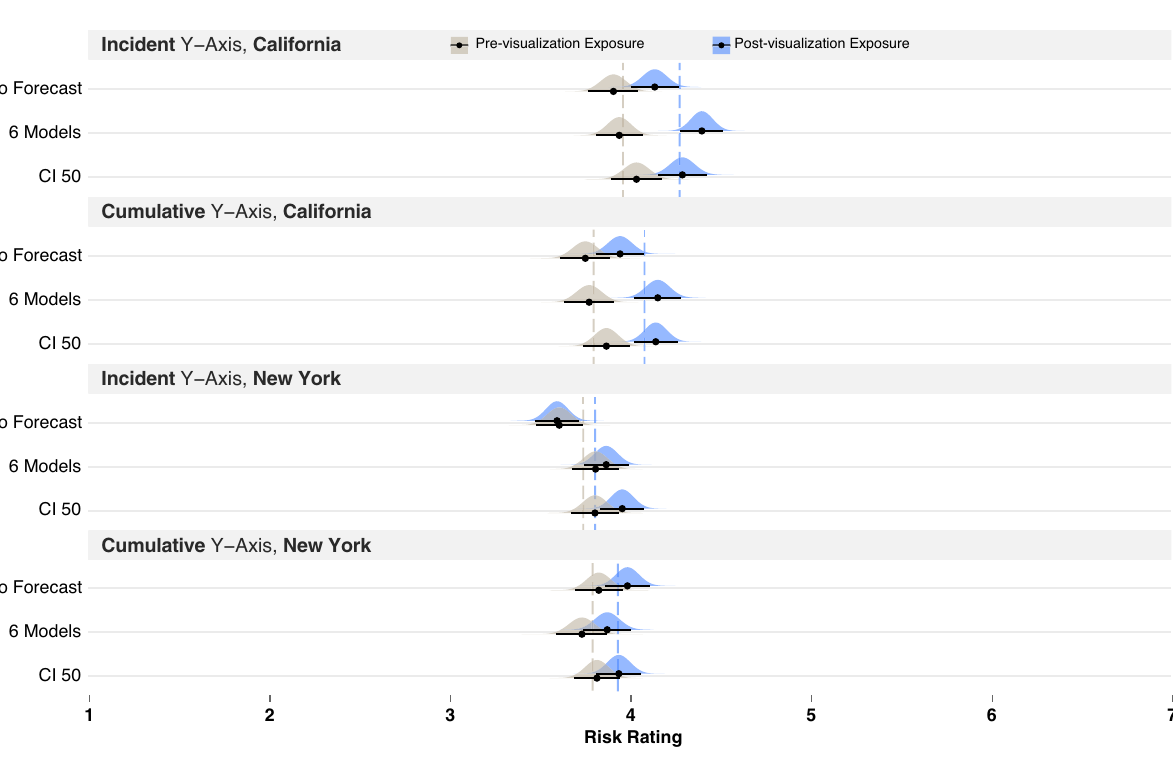
Figure 5. Results of the trend comparison in Experiment 2, where pre-visualization risk judgments are colored gray and post-visualization judgments blue, for cumulative y-axis (top) and incident y-axis (bottom). Dashed lines show the mean pre- and post-visualization risk judgments for each y-axis group as a whole. Black bars show 95% confidence intervals around the mean (black dot) for each condition using the Cousineau–Morey method 44 and the density plots were generated from this